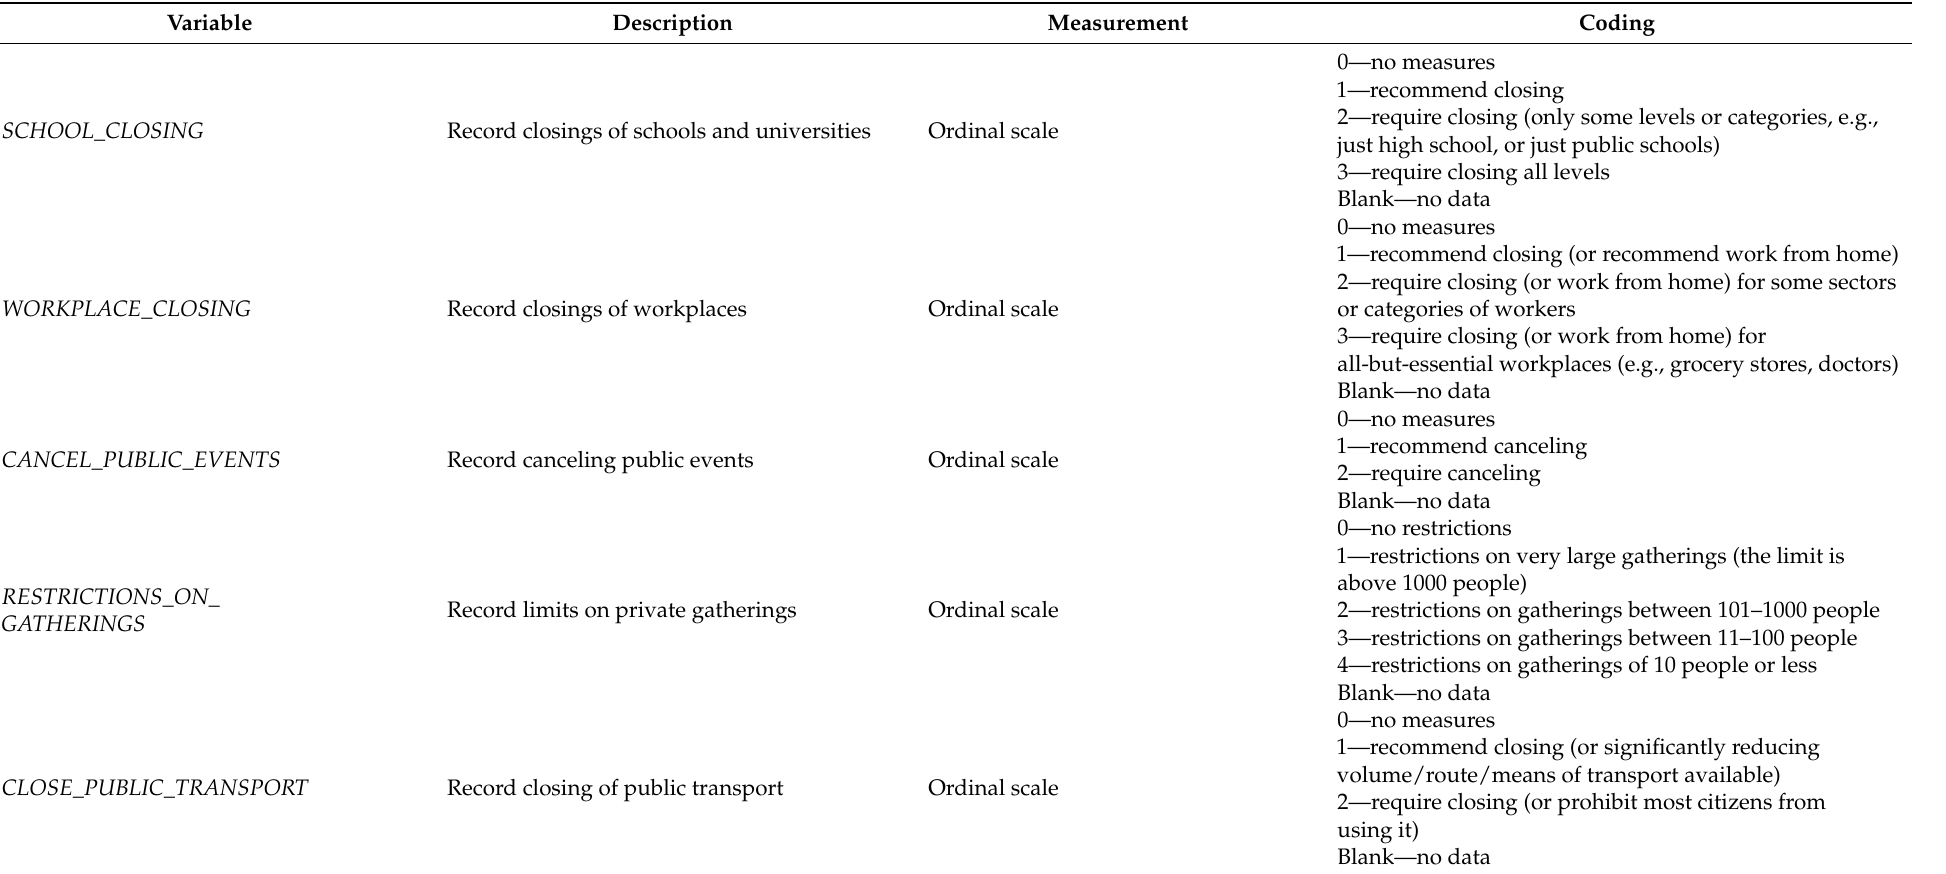
Table A2. Variable definitions of the eight containment and closure